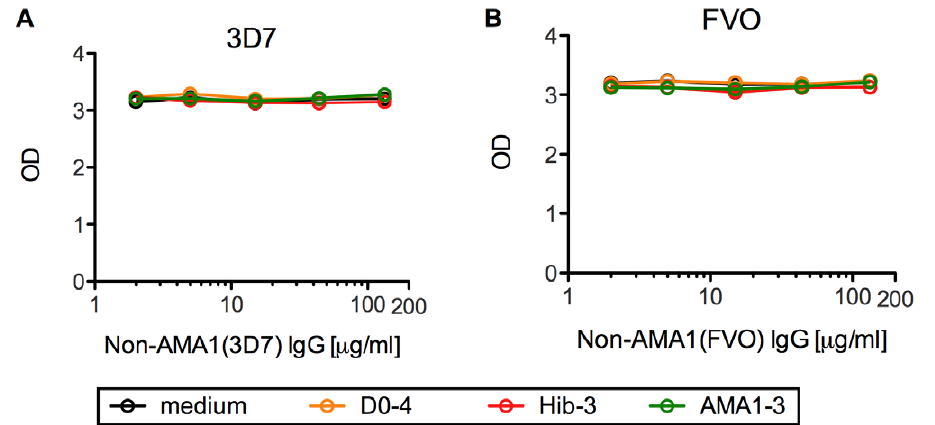
Figure 5. Competition ELISA with US-total IgG and non-AMA1 IgGs. (A) A fixed amount of US-total IgG, which gives approximately O.D. value of 3, was mixed with 3-fold dilutions of non-AMA1(3D7) IgGs from Malian children. The mixtures were tested by ELISA using an AMA1(3D7)- coated plate and the O.D. values are shown. (B) Similar study was performed using non-AMA(FVO) IgGs and an AMA1(FVO)-coated ELISA plate.